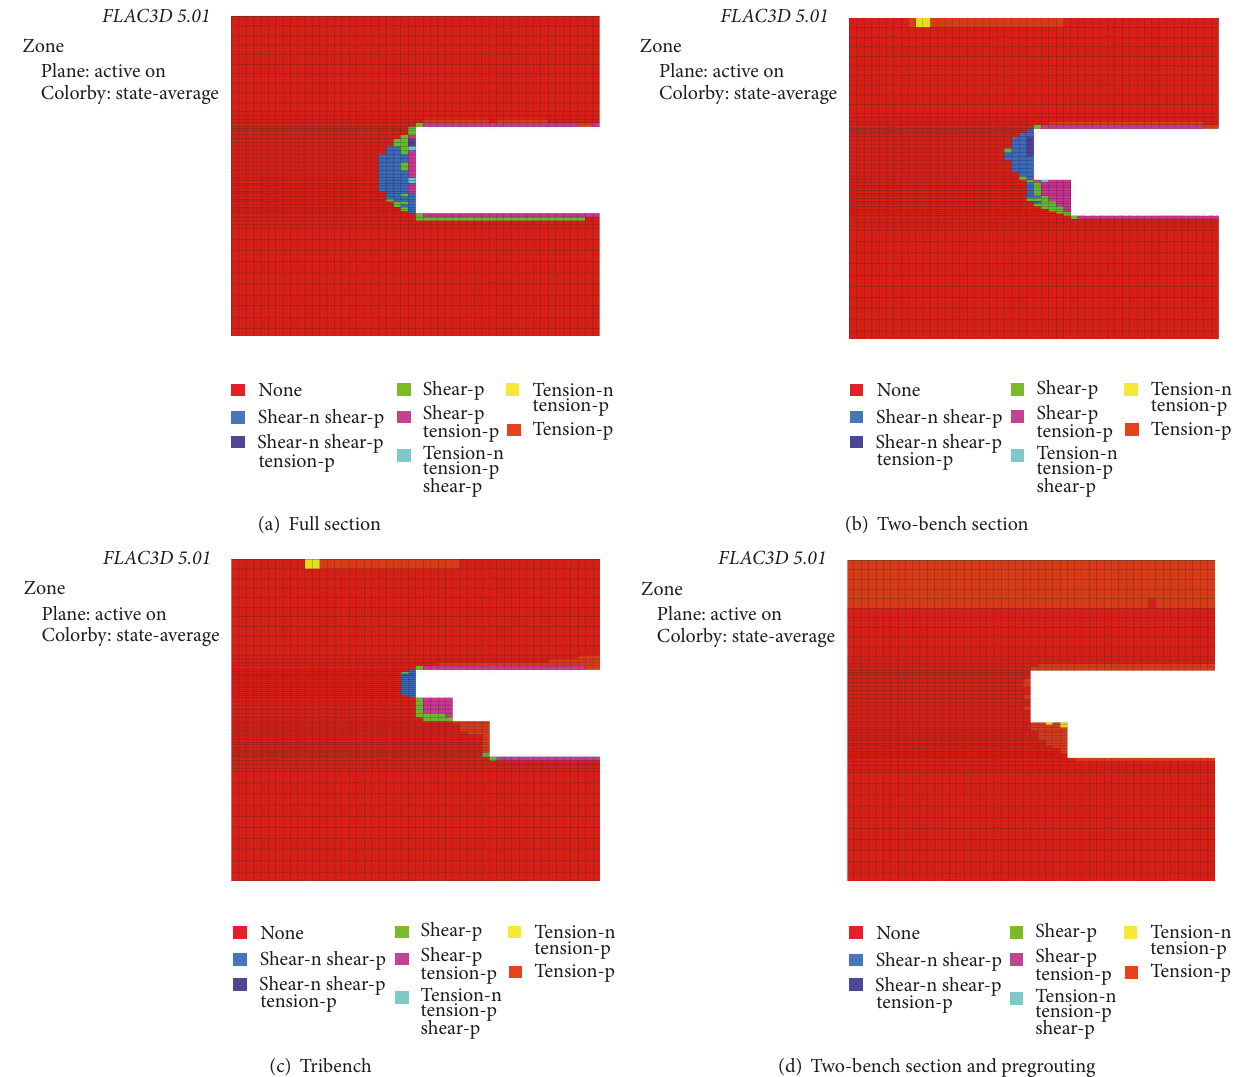
Figure 7: The distribution of the plastic zone